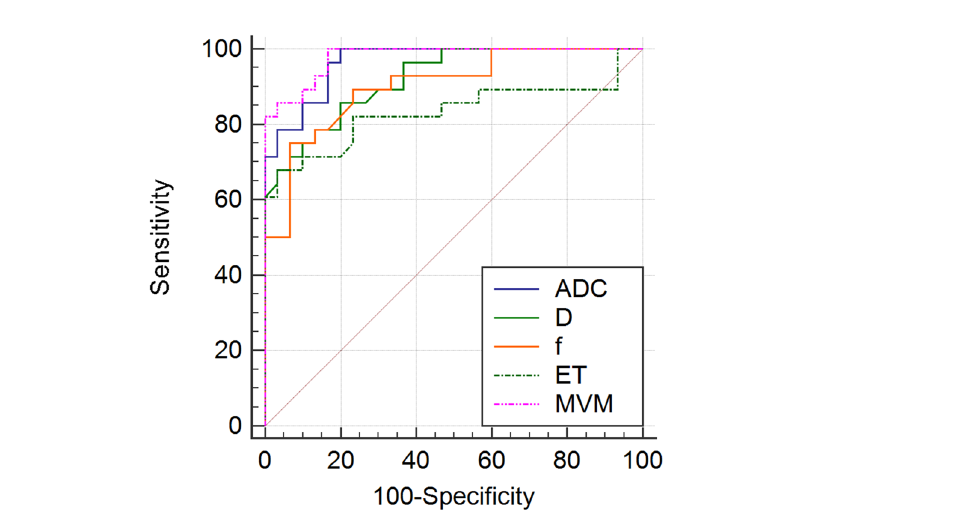
Figure 4. ROC curves for the performance of ADC, D , f values, ET and the multivariable model of ADC, D and f values for distinguishing patients with endometrial fibrosis and healthy women. ROC receiver operating characteristic, ADC apparent diffusion coefficient, AUC area under ROC curve, D true diffusion coefficient, f perfusion fraction, ET endometrial thickness, MVM a multivariable model combing ADC, D and f values using the binary logistic regression analysis.